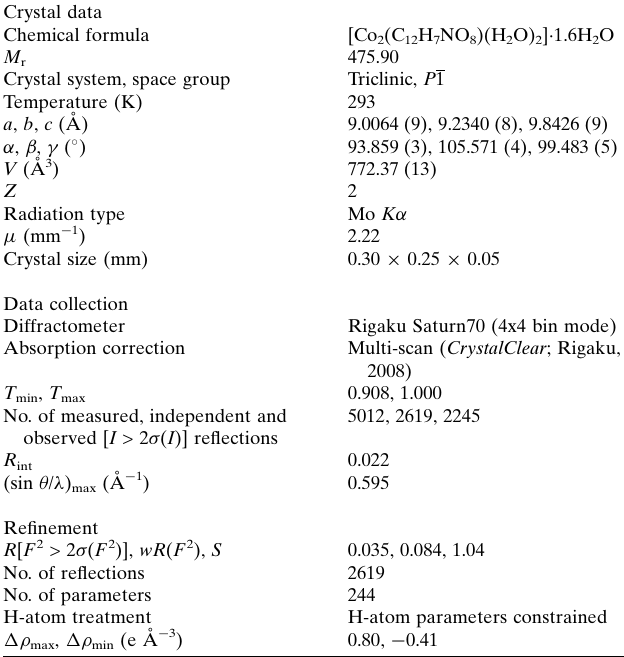
Table 3 Experimental details. Crystal data Chemical